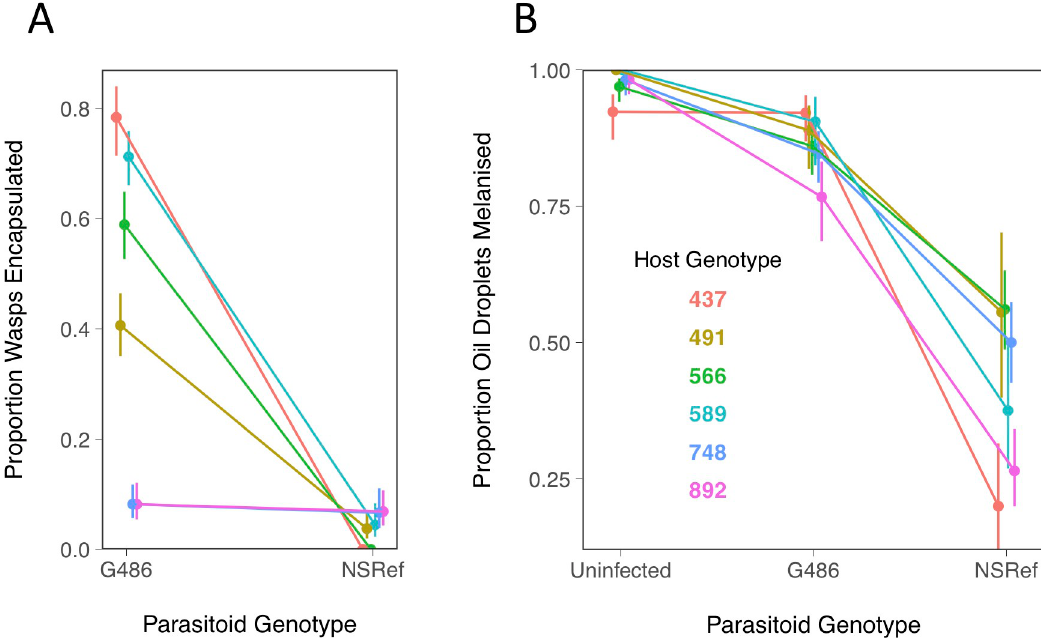
Fig 1. Resistance of six Drosophila genotypes to two parasitoid genotypes. (A) Proportion of Drosophila larvae encapsulating L . boulardi . (B) Proportion of oil droplets injected onto Drosophila larvae that were melanised. The larvae were previously parasitized by L . boulardi or were parasitoid-free controls. Bars are standard errors. Samples sizes per data point in panel A were a mean of 55 larvae and in panel B 38 larvae (full details are in S1